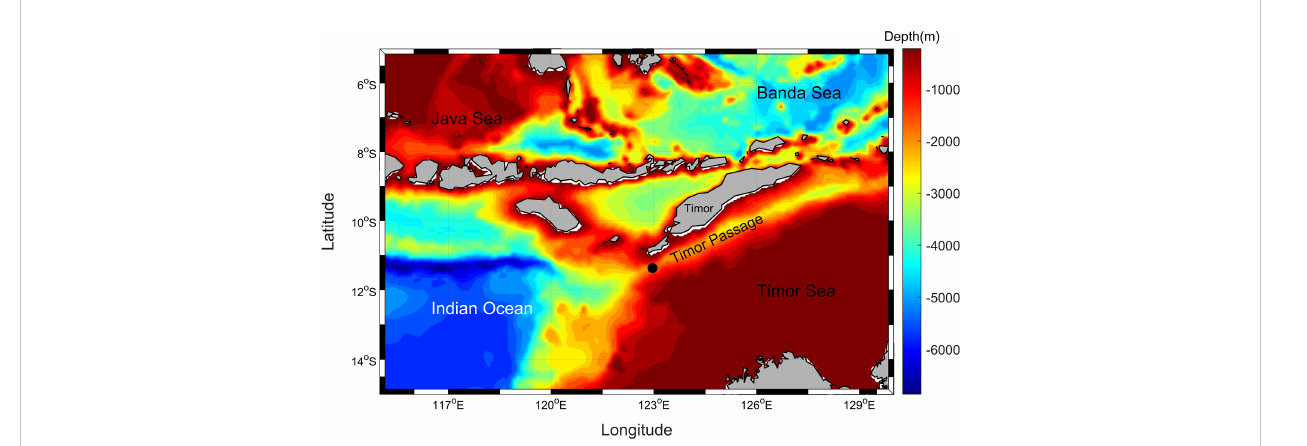
FIGURE 1 The location of the mooring (black dot). Water depths are from ETOPO1 dataset (Amante and Eakins,